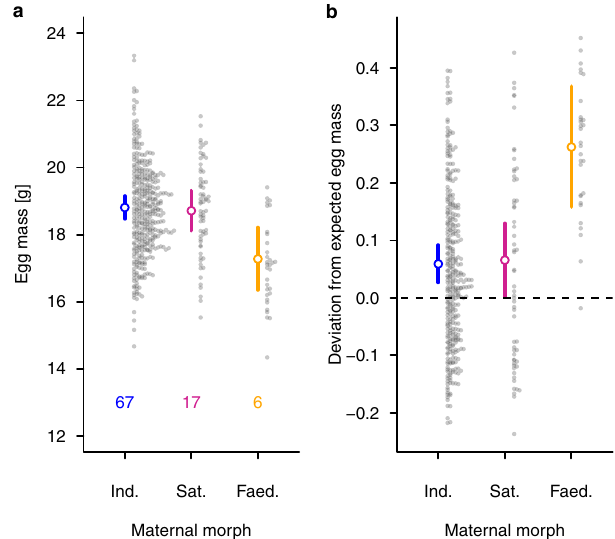
Fig. 1 Variation in egg mass by female morph. a Egg mass according to female morph when statistically controlled for female ID and sampling year. The probabilities of Faeder females ( N Eggs = 32, N Females = 6) laying lighter eggs than Independent ( N Eggs = 376, N Females = 67) or Satellite females ( N Eggs = 66, N Females = 17) were higher than 0.99, differences between Independent and Satellite females were not statistically clear. b Deviation of the observed egg mass from the egg mass expected according to female body mass ([observed egg mass/expected egg mass]-1) controlling for female ID and sampling year. Zero indicates the expected egg mass 41 . The probabilities of Faeder females ( N Eggs = 30, N Females = 5) having a higher deviation than Independent ( N Eggs = 345, N Females = 58) or Satellite ( N Eggs = 59, N Females = 14) females were both higher than 0.99. Given are means and 95% CrI for Independents in blue, Satellites in purple and Faeders in orange. Full model details are given in Supplementary Tables 2 and 3. Source data are provided as a source data fi